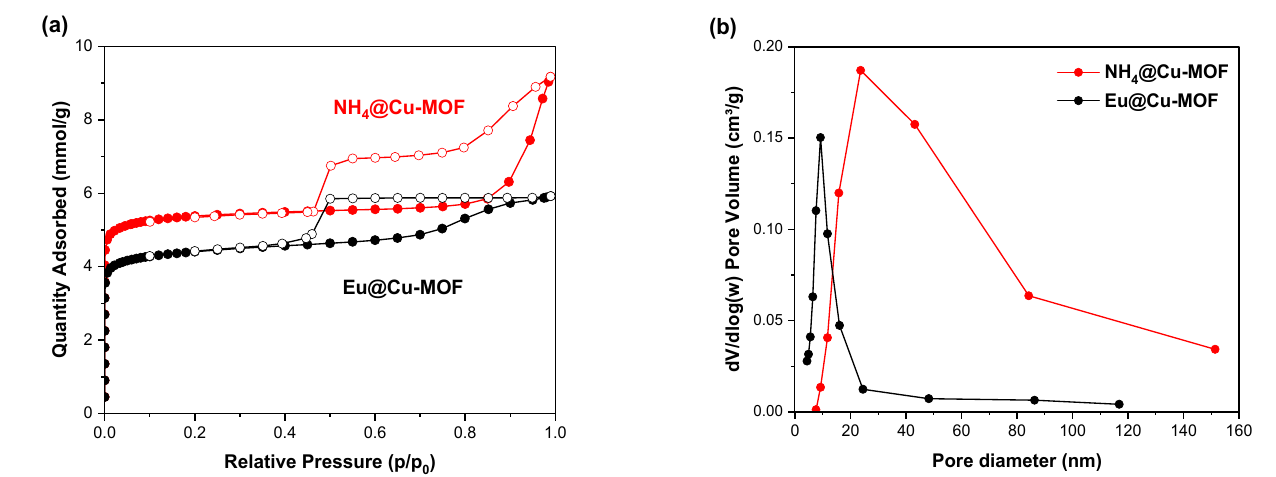
Figure 4. N 2 adsorption–desorption (77 K) isotherms ( a ) and pore size distribution ( b ) of NH 4 @Cu-MOF and Eu@Cu-MOF.